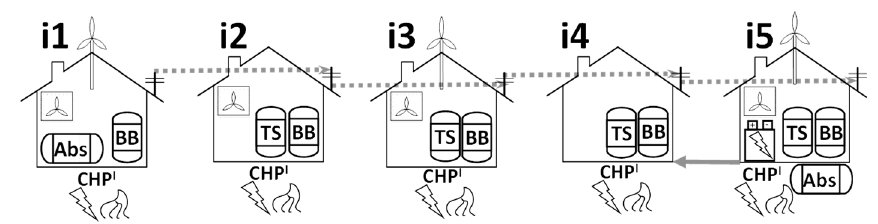
Figure 6. Design of the grid connected battery network with constant import pricing.